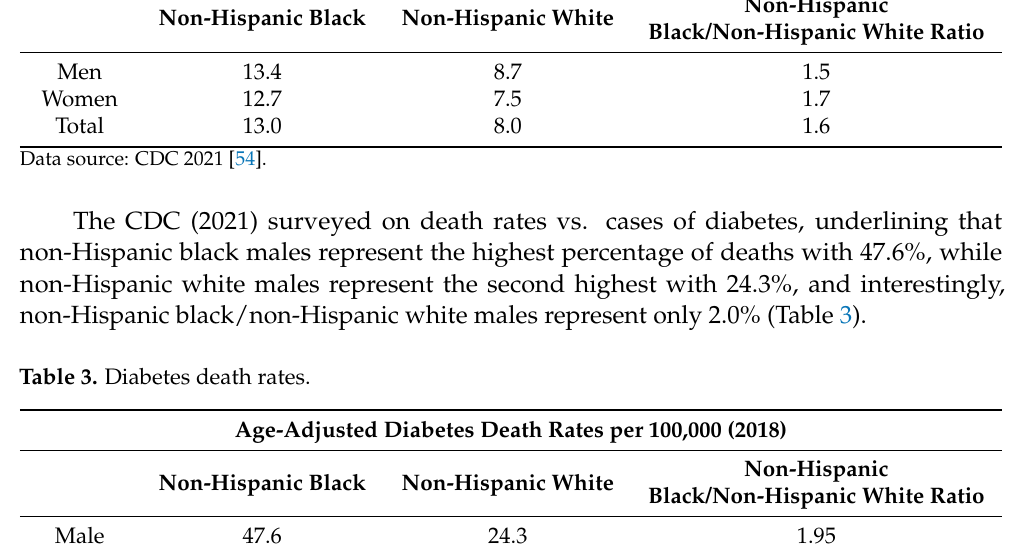
Table 2. Age-adjusted percentage of persons 18 years of age and over with diabetes, 2018. Non-Hispanic Non-Hispanic Black Non-Hispanic White Black/Non-Hispanic White Ratio Men 13.4 1.5 Women 12.7 7.5 1.7 Total 13.0 8.0 1.6